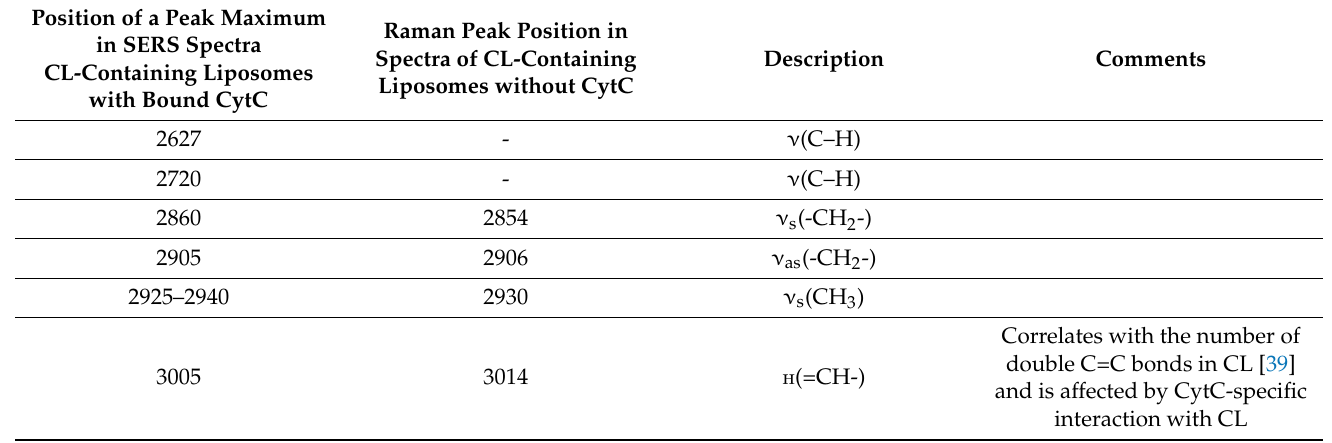
Table 1. Raman peak assignment (done in accordance with [38,39]).